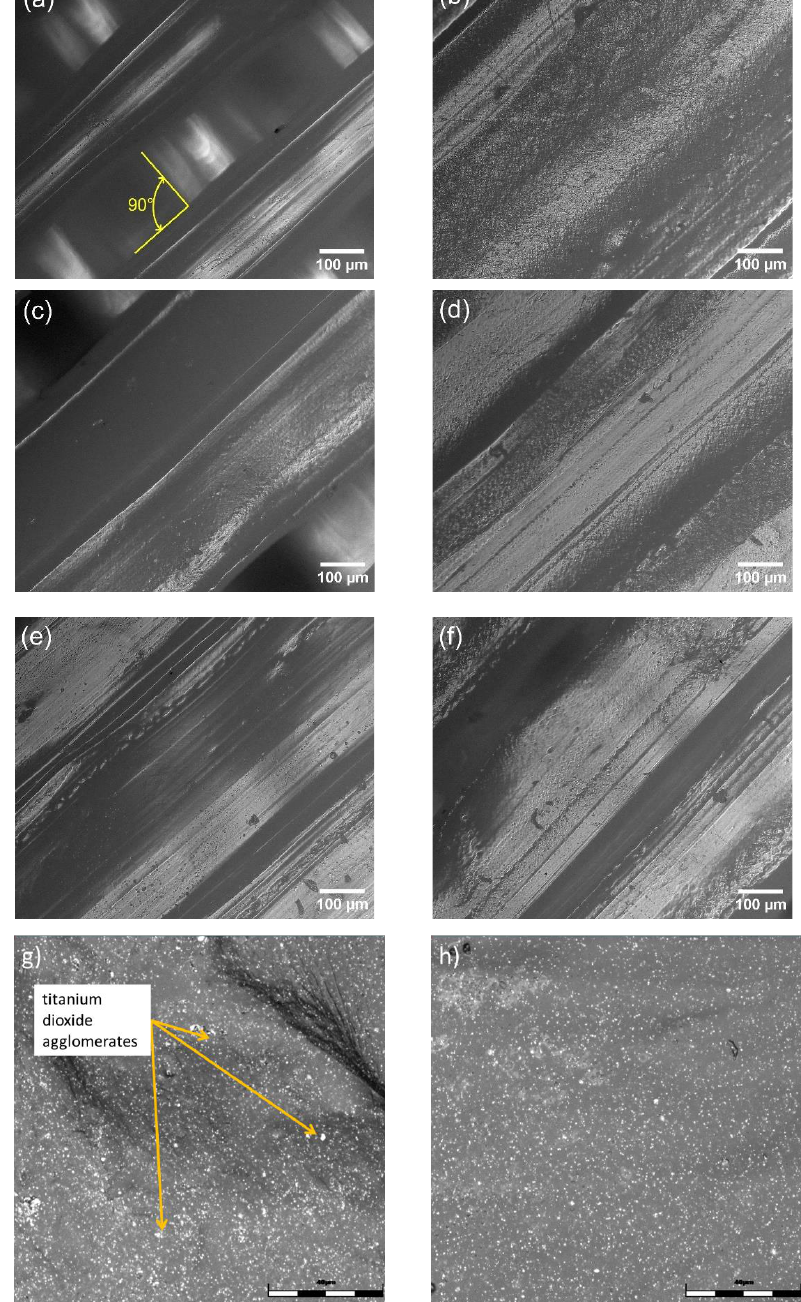
Figure 4. The filaments surface of: ( a ) PLA + 0.5% TiO 2 , ( b ) PLA + 1.5% TiO 2 , ( c ) PLA + 0.5% TiO 2 + 1.5% 8OD, ( d ) PLA + 1.5% TiO 2 + 1.5% 8OD, ( e ) PLA + 1.5% TiO 2 + 1.5% 5OD:3VT, ( f ) PLA +